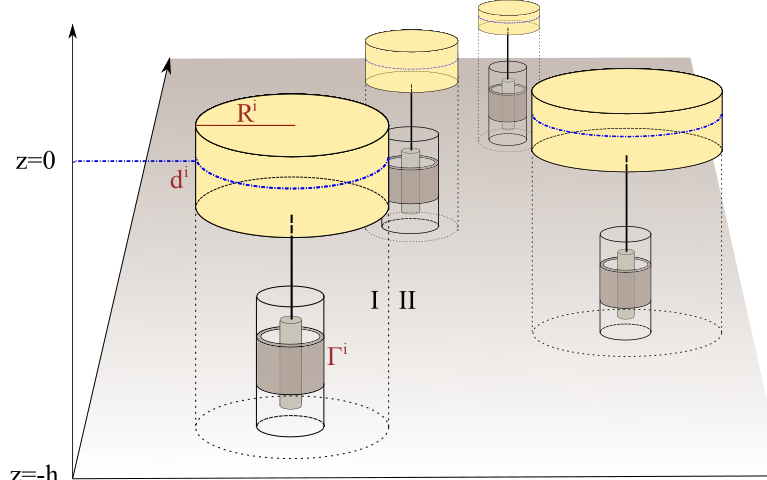
Figure 1. Illustration of the fluid domain of the wave energy park. Each wave energy converter is characterized by an individual radius R i and draft d i for the float and a power take-off damping Γ i of the generator. The fluid domain is divided into interior domains I for each float and exterior domain